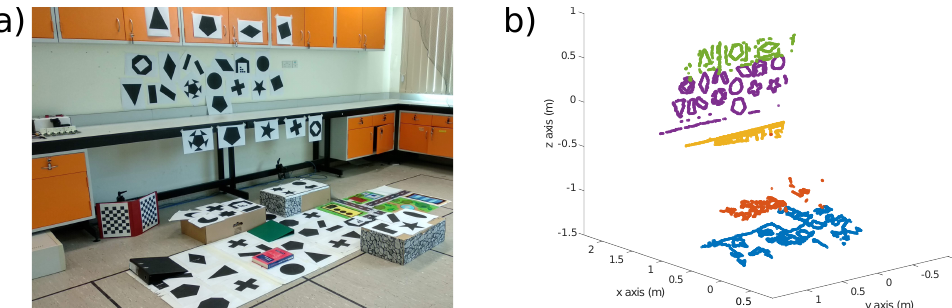
Figure 14. ( a ) Visual scene used for the dual-sensor experiment, with up to 60 cm difference in depth. ( b ) Point cloud obtained at time 13.5 s (i.e., after two keyframes have been triggered for each sensor) during the experiment with the dual sensor where the EMVS mapping is performed. The different colors represent the different planes contained in the